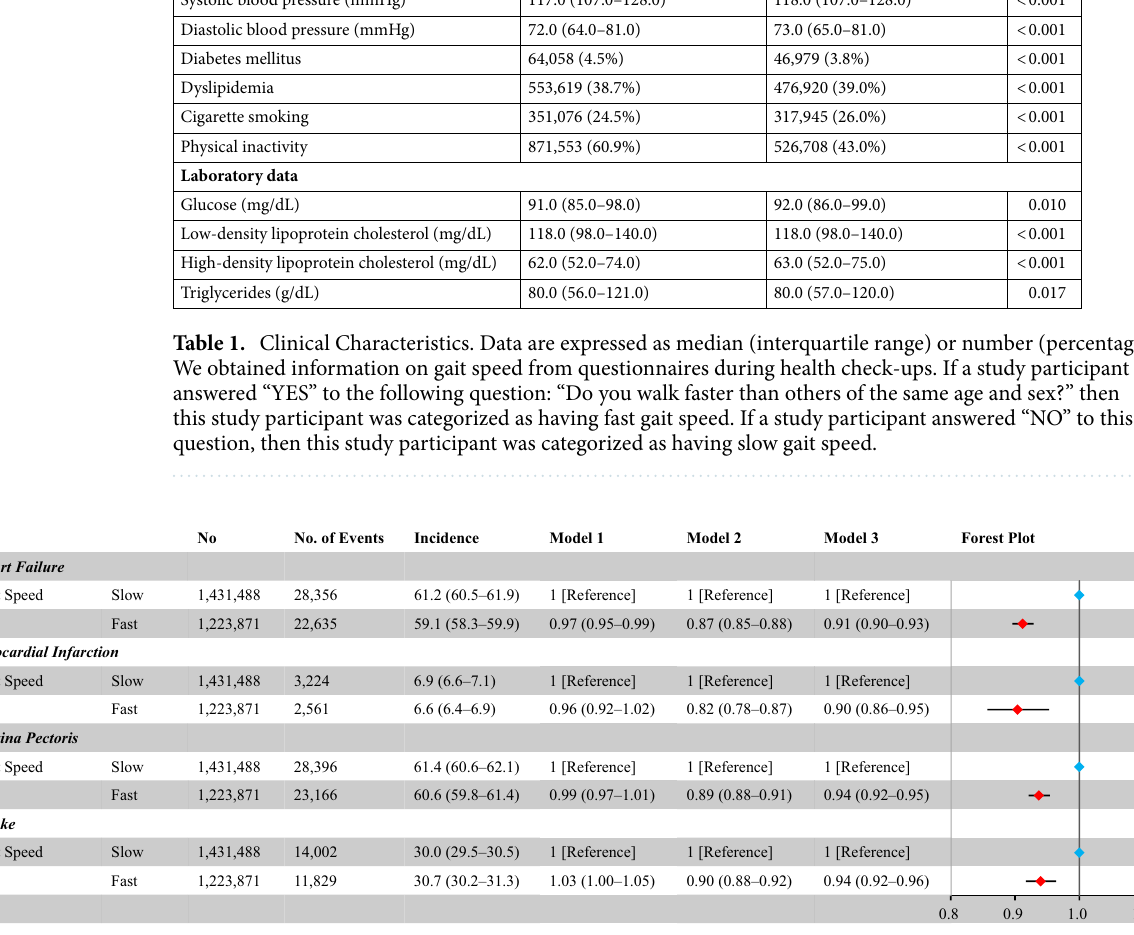
Figure 2. The frequency of events, corresponding incidence rates, and hazard ratios of fast gait speed for cardiovascular disease events. The incidence rate was per 10,000 person-years. Cox regression analyses; Model 1 included fast gait speed alone (unadjusted model); model 2 included the hazard ratios (HRs) of fast gait speed adjusted for age and sex, and model 3 included the HRs of fast gait speed adjusted for age, sex, obesity, hypertension, diabetes mellitus, dyslipidemia, cigarette smoking, and physical tary Table 1. The results of the subgroup analyses are summarized in Fig. 3. The association between fast gait speed and the risk of HF incidence was consistent in each subgroup. Fast gait speed was associated with a lower incidence of HF (HR 0.91, 95% CI 0.89–0.93) even in participants whose follow-up period for HF was longer than one year (Supplementary Table 2). Our main results were unchanged after adjustment for a prior history of peripheral artery disease (Supplementary Table 3).